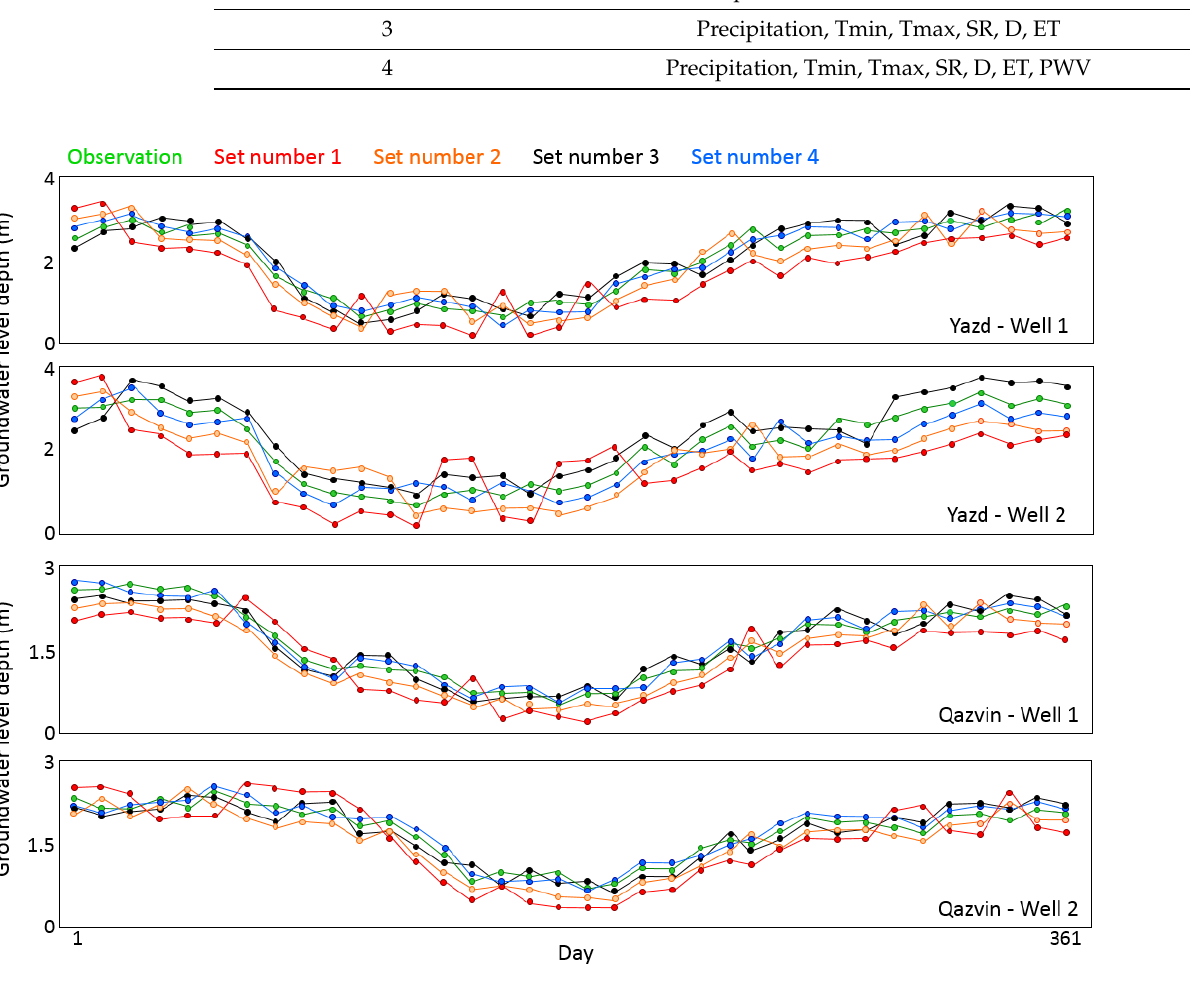
Figure 12. Comparison between groundwater level simulation from different input sets and obser- vation in 2020 . tion in Table 7. The statistical results of different input sets of ANN .